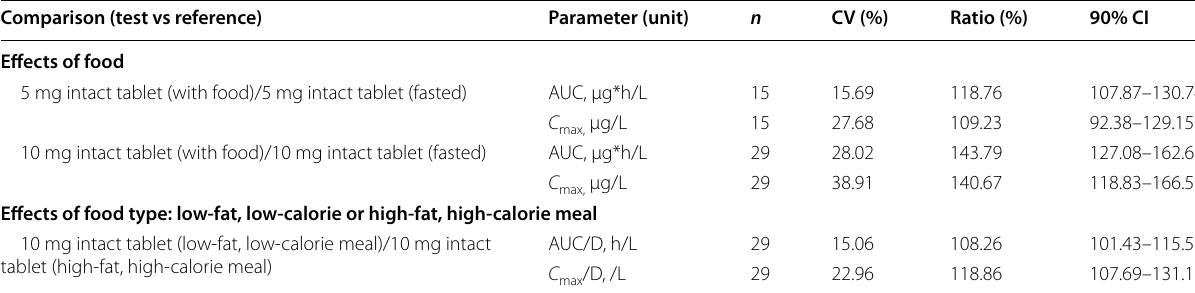
Geometric CV indicating intra-individual variability ANOVA Analysis of variance, AUC Area under curve, AUC/D Dose-normalized area under the curve, CI Confidence interval, C max Maximum plasma concentration, C max /D Dose-normalized maximum plasma concentration, CV Coefficient of variation, IR Immediate release, LS Least squares, PK Pharmacokinetic Ratio: LS means for the respective treatment ratio calculated by ANOVA